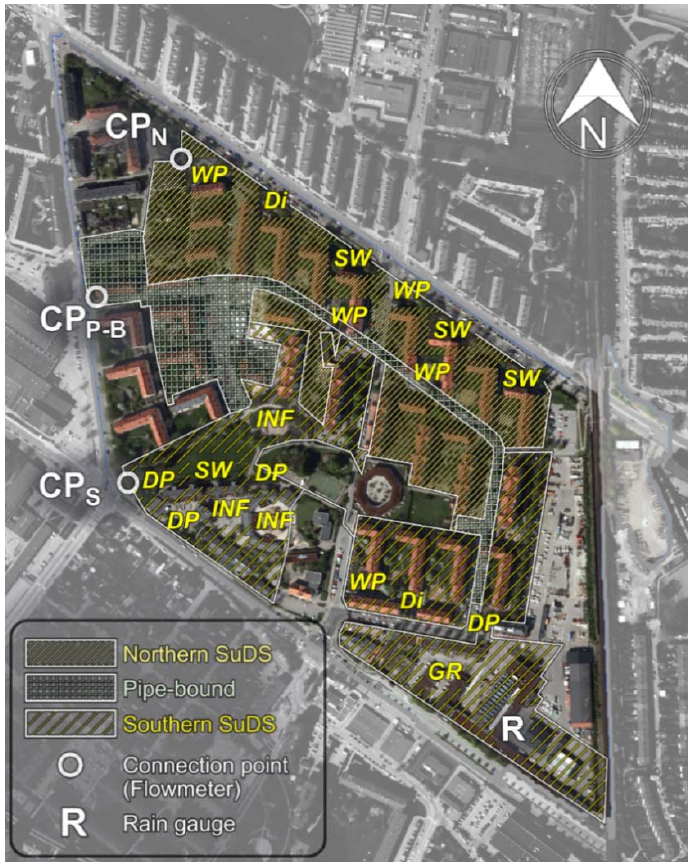
Figure 2. The locations of rainfall and runoff monitoring points as well as the catchment delineation in Augustenborg. The unmarked areas within the borders of the Augustenborg area are directly drained into the existing municipal pipe-bound combined sewer network. Connection points marked as CP N , CP P-B , and CP S are the discharge points for the Northern retrofit, the pipe-bound catchment, and the Southern retrofit, respectively. Note that the flow is in the north-west direction, i.e., towards